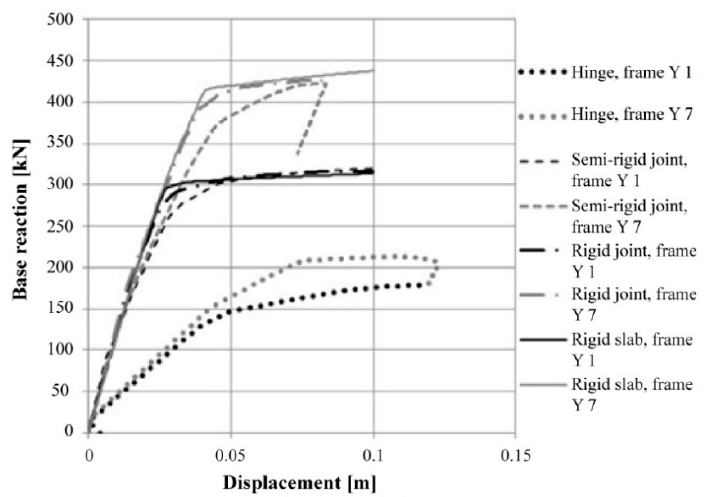
Figure 14. Non-linear static curves in the longitudinal ( Y ) direction.